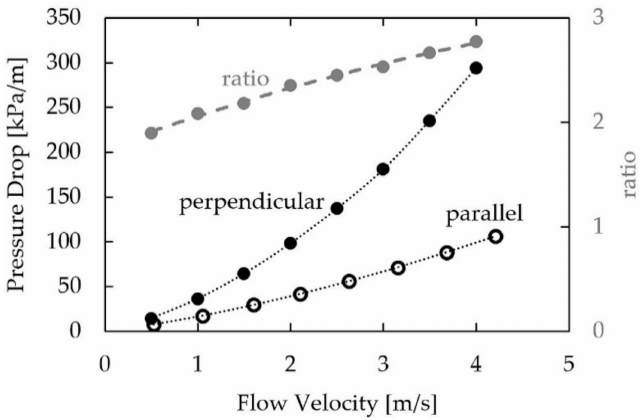
Figure 14. Pressure drop of an expanded sheet metal structure parallel and perpendicular to the layers and the ratio of the pressure drop in different